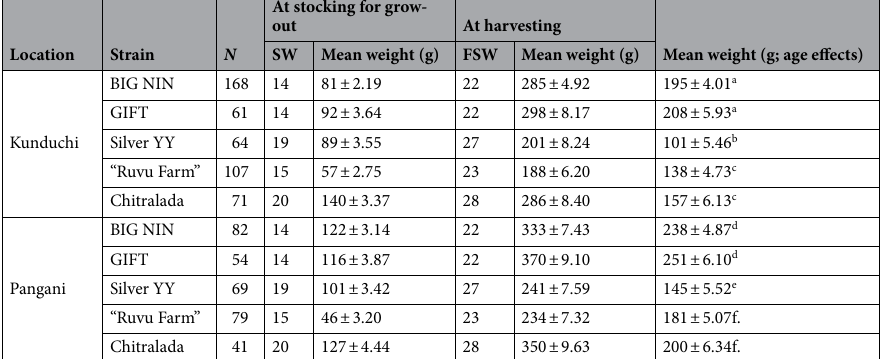
Table 2. Stocking, harvesting and age effect mean weights (± s.e) of Nile tilapia strains reared at Kunduchi and Pangani experimental sites. Superscripts shown at each mean weight (age effect) indicate the various levels of significant difference (p < 0.0001) by the F- test. n -Number of samples, SW-Survived weeks from fry collection to stocking, FSW-Final survived weeks from fry collection to